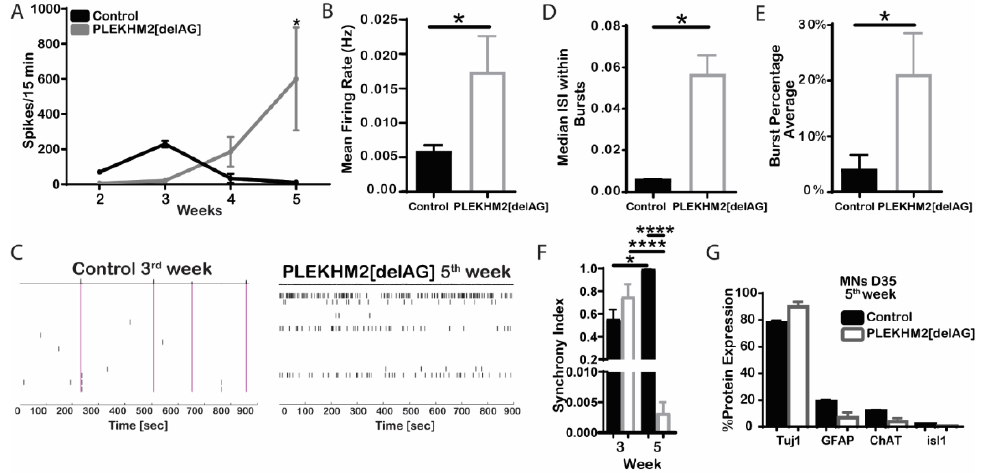
Figure 4. Microelectrode array (MEA) functional assay of the cultures. ( A ) Number of spikes fired during a 15 min recording. Based on at least four separate independent experiments (BGUi008A—2, BGUi008B—2, BGUi009—2 and BGUi010—3) * p = 0.025 by one-way ANOVA with Sidak’s multiple-comparisons test. ( B ) Mean firing rate * p = 0.0171 by two-tailed student’s t-test. Presenting mean ± SEM. ( C ) Representative raster plots during the most active week in the culture. ( D ) Median inter-spike interval (ISI) within bursts * p = 0.0214 by two-tailed student’s t -test. ( E ) Burst percentage average * p = 0.0345 by two-tailed student’s t -test. All graphs presenting mean ± SEM. ( F ) Synchrony index during weeks 3 and 5 * p = 0.0130, **** p < 0.0001, respectively, by two-tailed student’s t-test, showing mean ± SEM. Week 3: n control = 7, n PLEKHM2[delAG] = 3. Week 5: n control = 2, n PLEKHM2[delAG ] = 7. ( G ) Protein expression of day 35 neural culture. Two- tailed student’s t -test, showing mean ± SEM, n = 2.